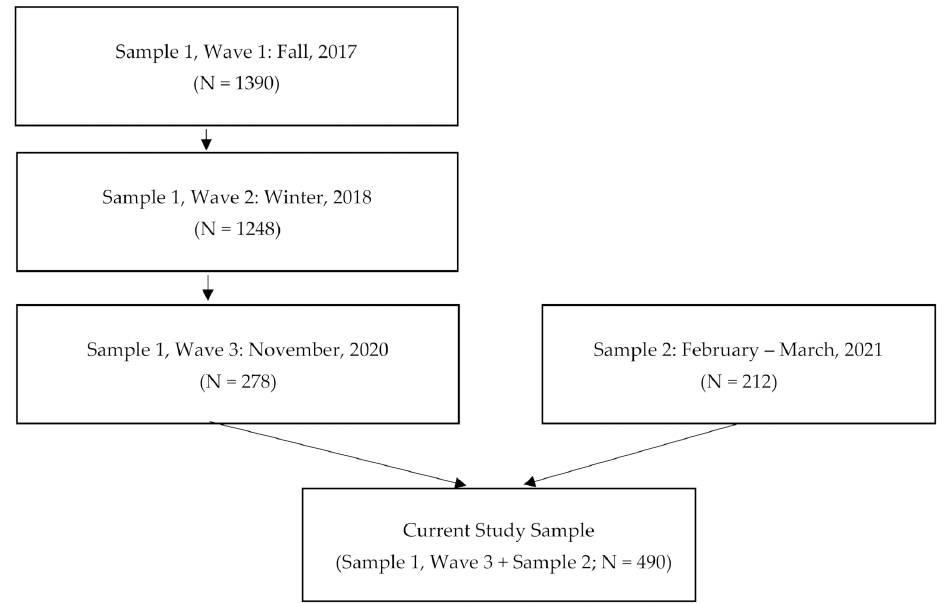
Figure 1. Flowchart of participant recruitment for the present study. The sample for the current study was derived from two independent samples. Data from Sample 1 were collected in three waves. Sample 1, Wave 1 was collected in the fall of 2017; Sample 1, Wave 2 was collected in the winter of 2018; and Sample 1, Wave 3 was collected in the fall of 2020. For Sample 1, demographic data were collected at Wave 1 and impulsivity data were collected at Wave 2. All COVID-19-related variables were collected at Wave 3. Data for Sample 2 were collected at a single timepoint between January and February 2021. The total sample size (N = 490) for the current study is comprised of Sample 1, Wave 3 plus Sample